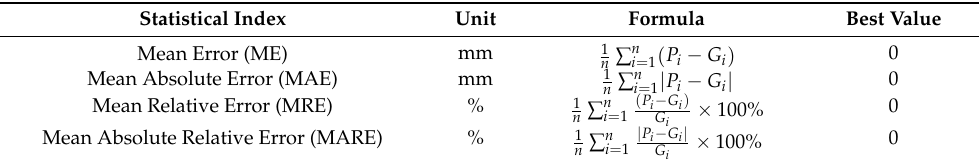
Table 2. List of the validation statistical indices used to compare the QPE of the FY-4A AGRI and the